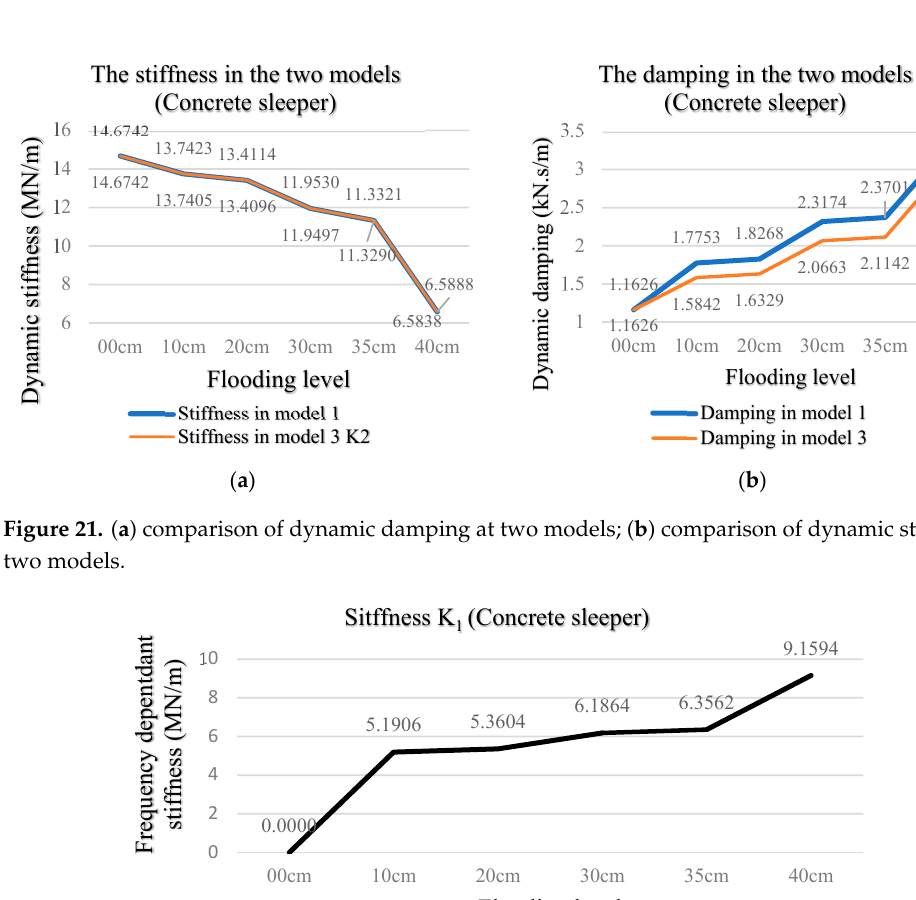
Figure 22. Sti ff ness K 1 in Figure 22. Stiffness K 1 in Model-3.